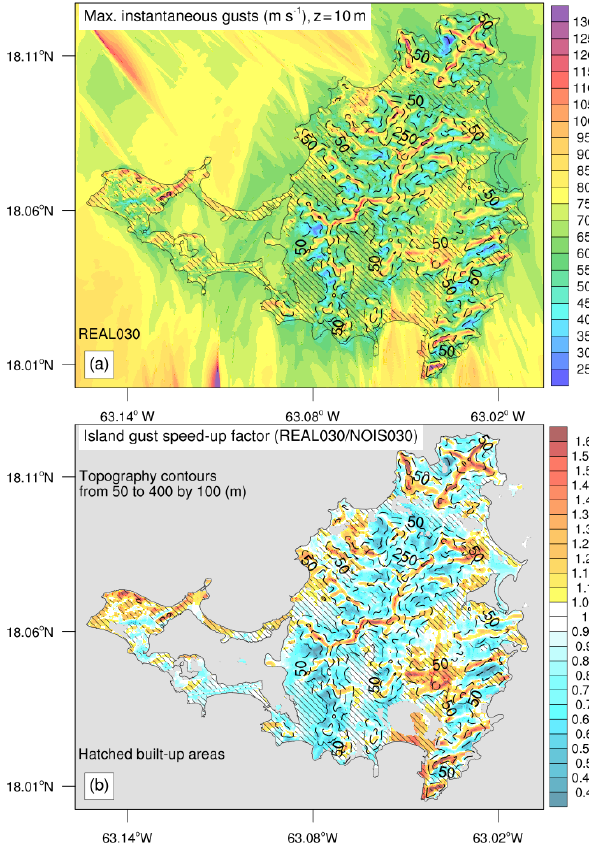
Figure 11. Saint Martin 30m scale maximum surface winds during the 6h of simulation (history output interval of 1min). (a) Max- imum instantaneous gust (ms − 1 ). (b) Island gust speed-up factor (REAL030/NOIS030). Topography contours in meters and hatched built-up areas are plotted on the two